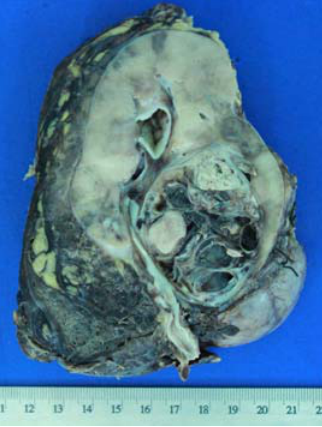
Figure 2: Gross photograph of the cut surface of the right kidney showing a heterogeneous tumor